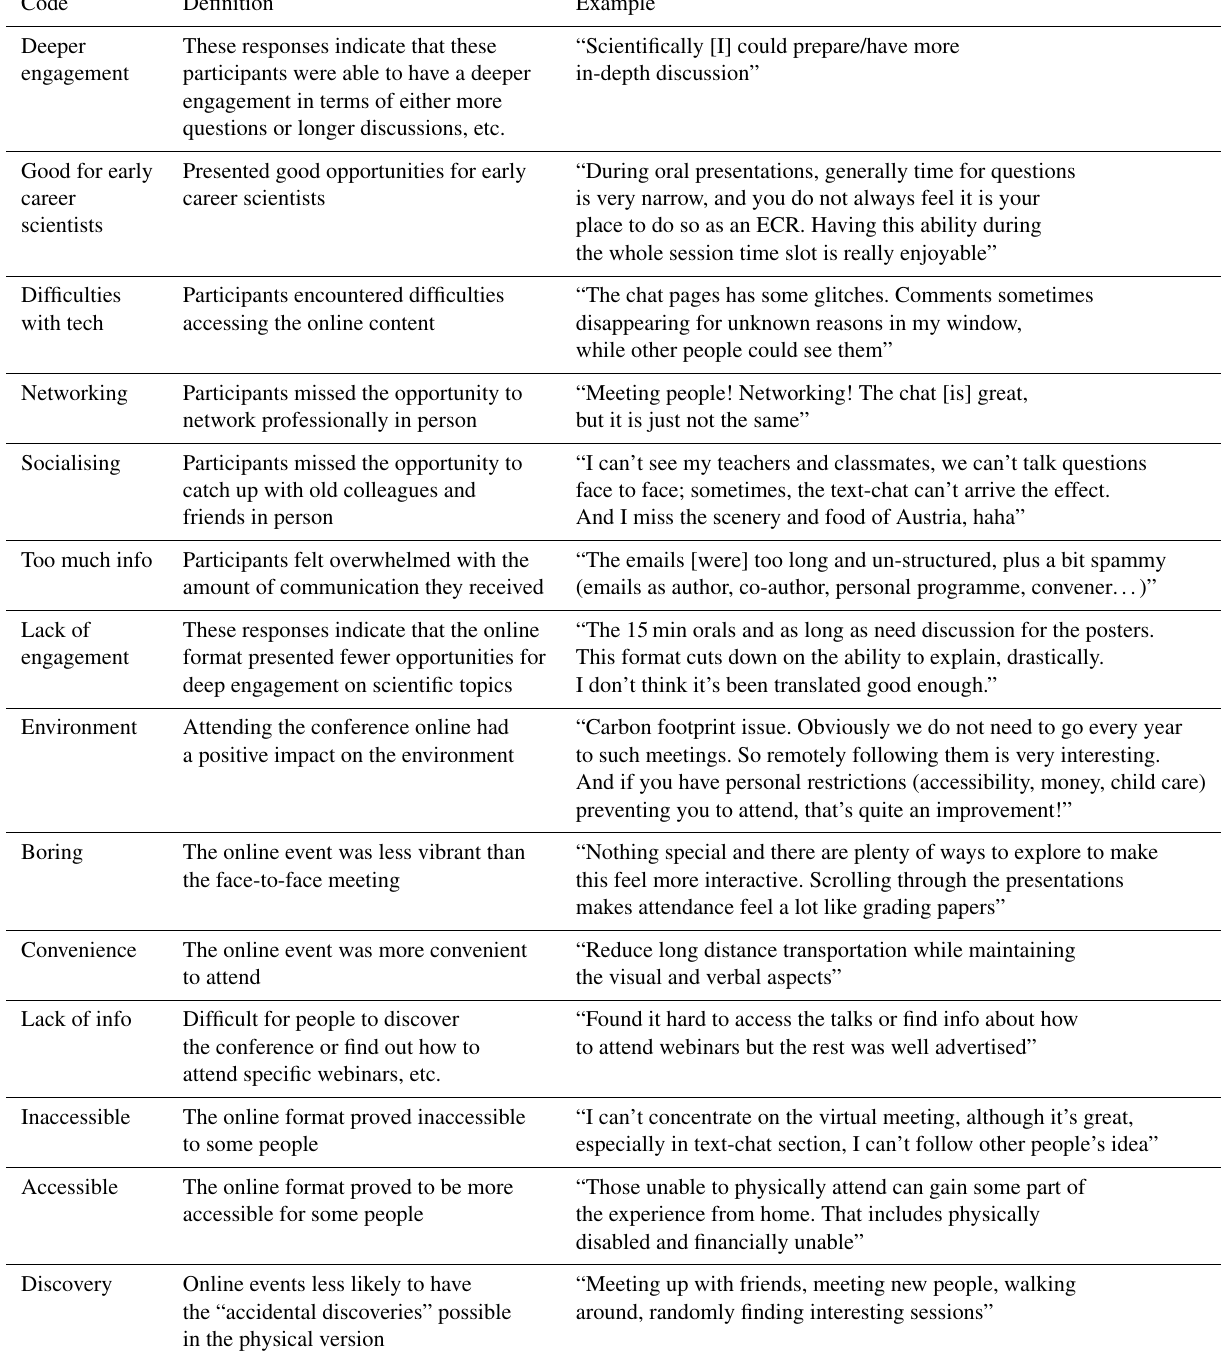
Table 2. The code book that was used by Sam Illingworth in the initial coding exercise, including a definition and an example for each code.